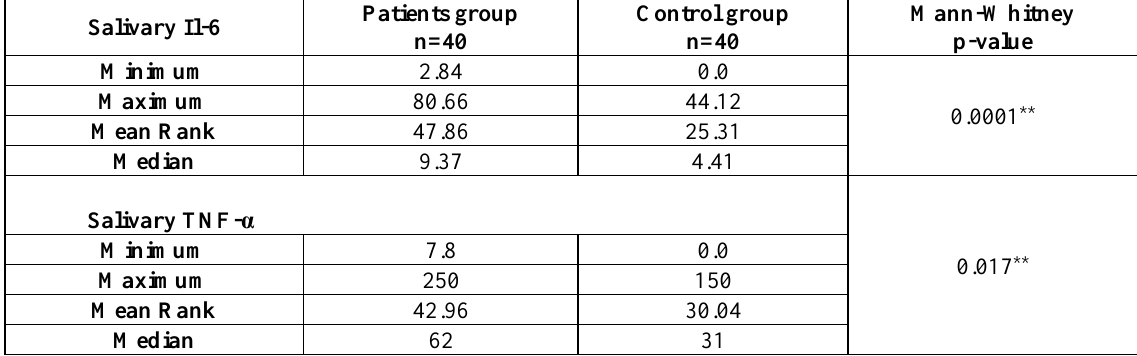
Table 5: Salivary Levels of IL-6 and TNF-α (pg/ml) in Patient and Control Groups.